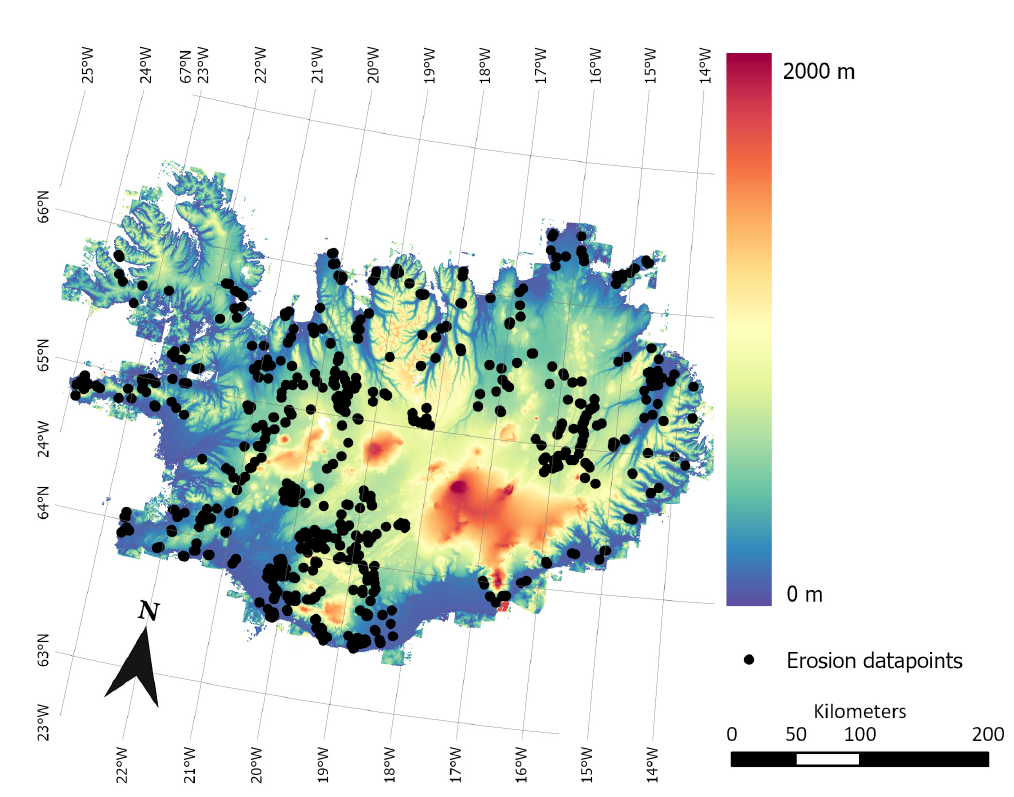
Figure 1. Map of Iceland. The regions where soil erosion measurements were taken by Landgræðslan are marked by black circles. Altitude is indicated by the color